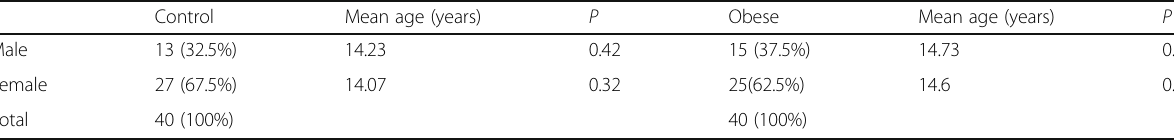
Table 1 Sex and age distribution in control and obese groups